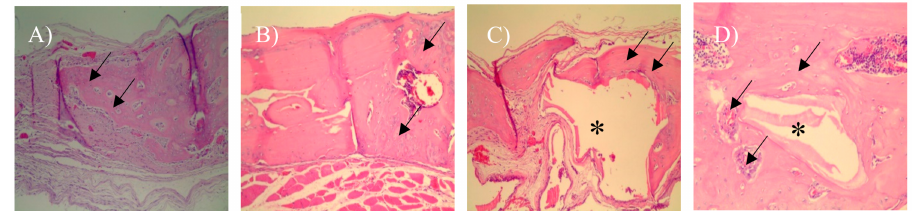
Figure 6. Histological images after 30 days (100 × magnification) . ( A ) Blood clot group (G1), arrows indicate new bone formation; ( B ) autogenous bone group (G2), observe the new bone formation between the bone particles; ( C ) xenogenous bone group (G3)—the asterisks show the Bio-Oss ® particles, observe the new bone formation indicated by the arrows; ( D ) xenogenous bone associated with the micro graft group (G4)—observe the new bone formation around the Bio-Oss ® particles and the presence of blood vessels.